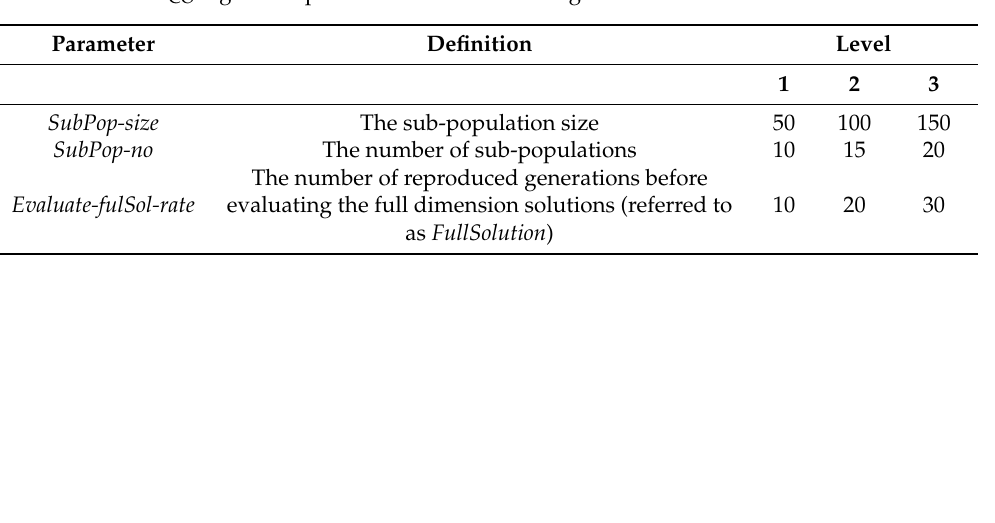
Table 1. The BBA CO algorithm parameter levels for the Taguchi